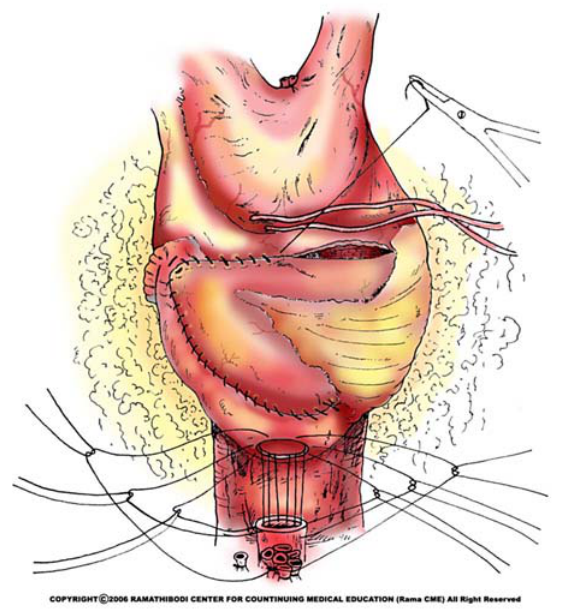
Figure 4 – Studer’s ileal neobladder is placed using 5 stitches of polyglycolic acid seromuscular